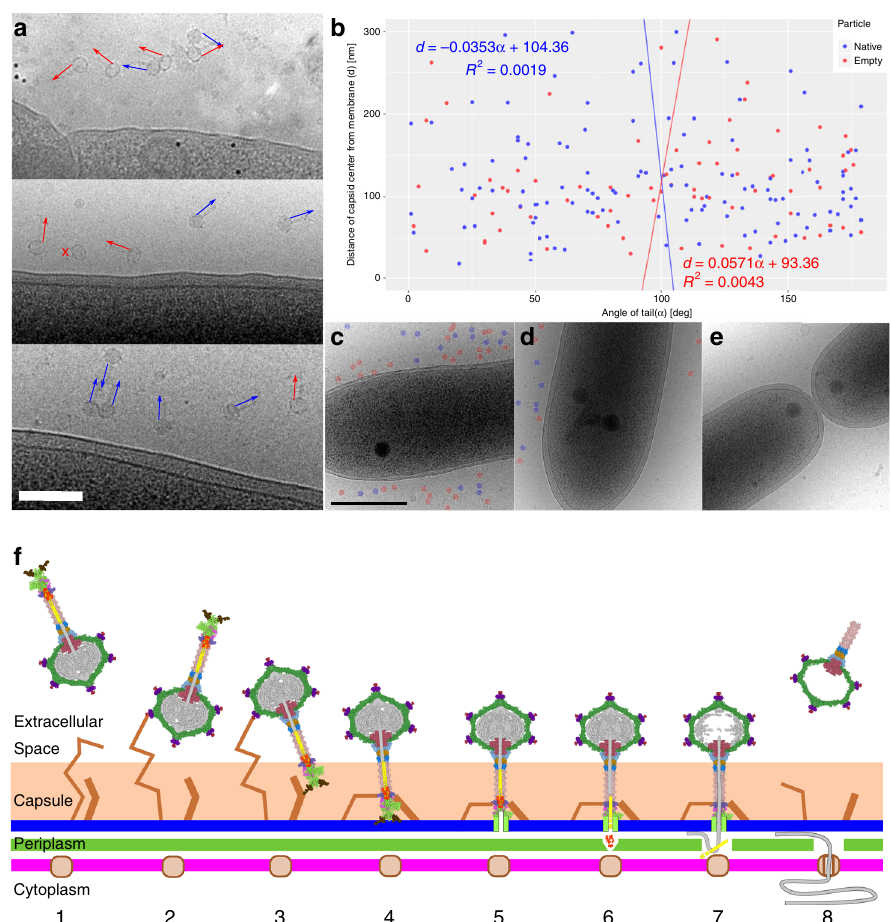
Fig. 6 Mechanism of DNA delivery by RcGTA. a , b RcGTA particles attach to cells in random orientations. a Cryo-electron micrographs of particles of RcGTA attached to cells of R. capsulatus . The panel includes images from three biological replicates. Orientations of RcGTA tails are highlighted with arrows. Blue indicates genome-containing particles and red empty ones. A cross next to a particle indicates that its tail is not visible in the projection image. Black dots are fi ducial markers. Scale bar represents 200 nm. b Distribution of orientations of tails of RcGTA particles ( x -axis) versus distance of capsid center from outer cell membrane ( y -axis). The tail orientation has values from 0°, when the tail points at the membrane, to 180°, when the tail points away from membrane. The particles are oriented randomly. c – e Cells of R. capsulatus are heterogeneous in their capacity to bind RcGTA. Electron micrographs of three R. capsulatus cells from the same experiment using multiplicity of Rif-transferring RcGTA of 0.0002. Some cells were covered with numerous RcGTA particles ( c ), some had tens of them attached ( d ), whereas the remaining ones only attracted a few ( e ). Native and empty RcGTA particles are highlighted with blue and red circles, respectively. f Model of RcGTA-mediated DNA delivery. (1) Free particle. (2) RcGTA attaches to the cell capsule by the head fi bers. (3) Particle reorients by the binding of tail fi bers to outer membrane receptors. (4) Particle attaches to the membrane by putative receptor-binding domains of the baseplate. (5) Penetration of the outer membrane by iris/penetration domain of megatron protein. (6) Ejection of cell-wall peptidase into periplasm enables degradation of cell wall. (7) Ejection of tape measure protein with DNA to periplasmic space. (8) Uptake of DNA by cell competence